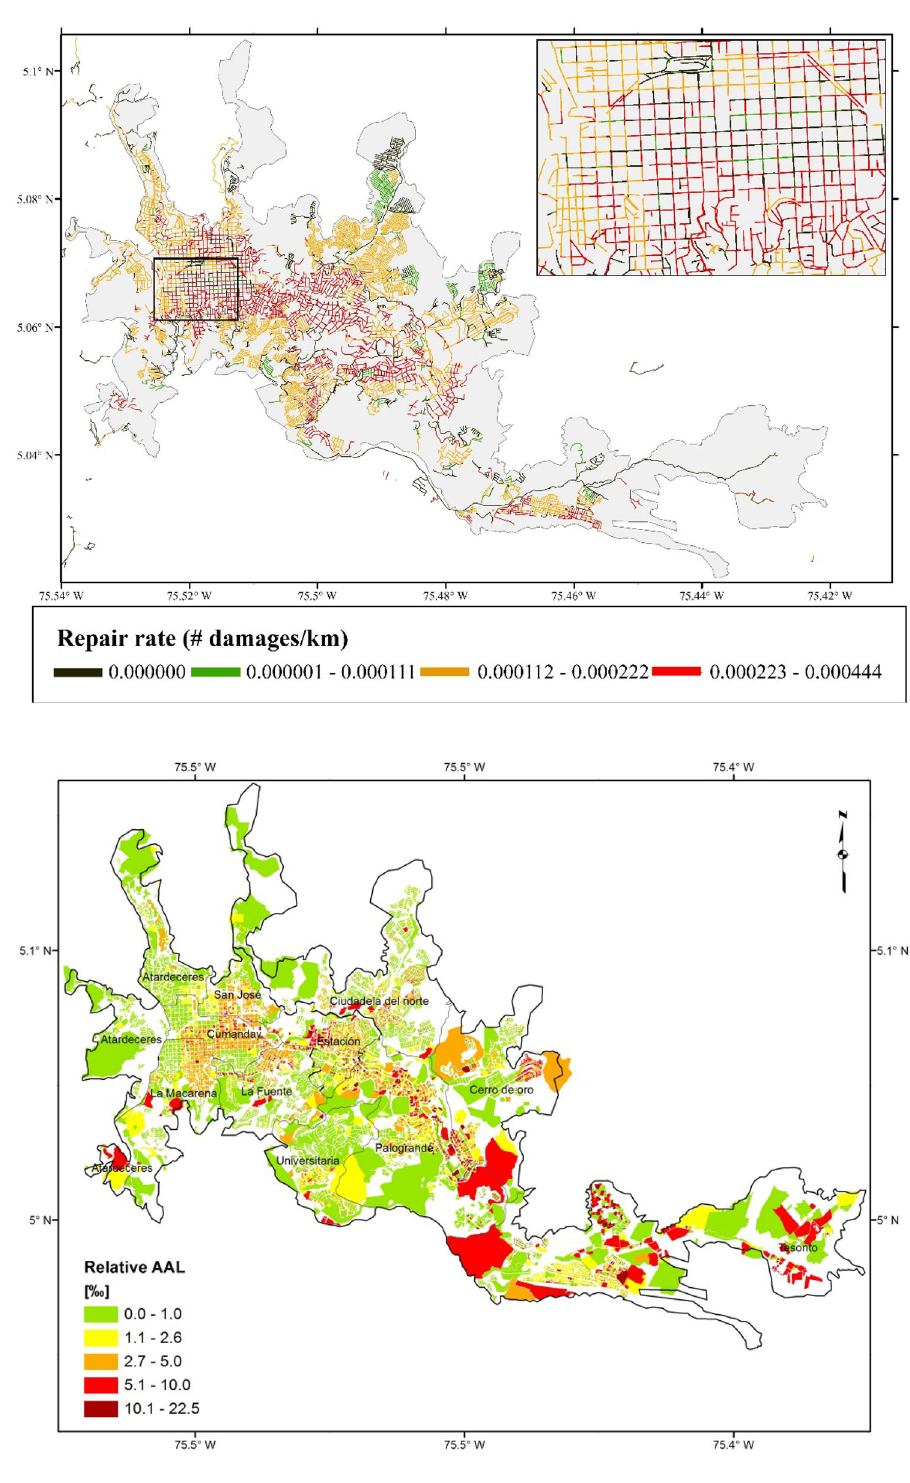
Fig. 3 Average annual repair rates (RR/km) for the sewage